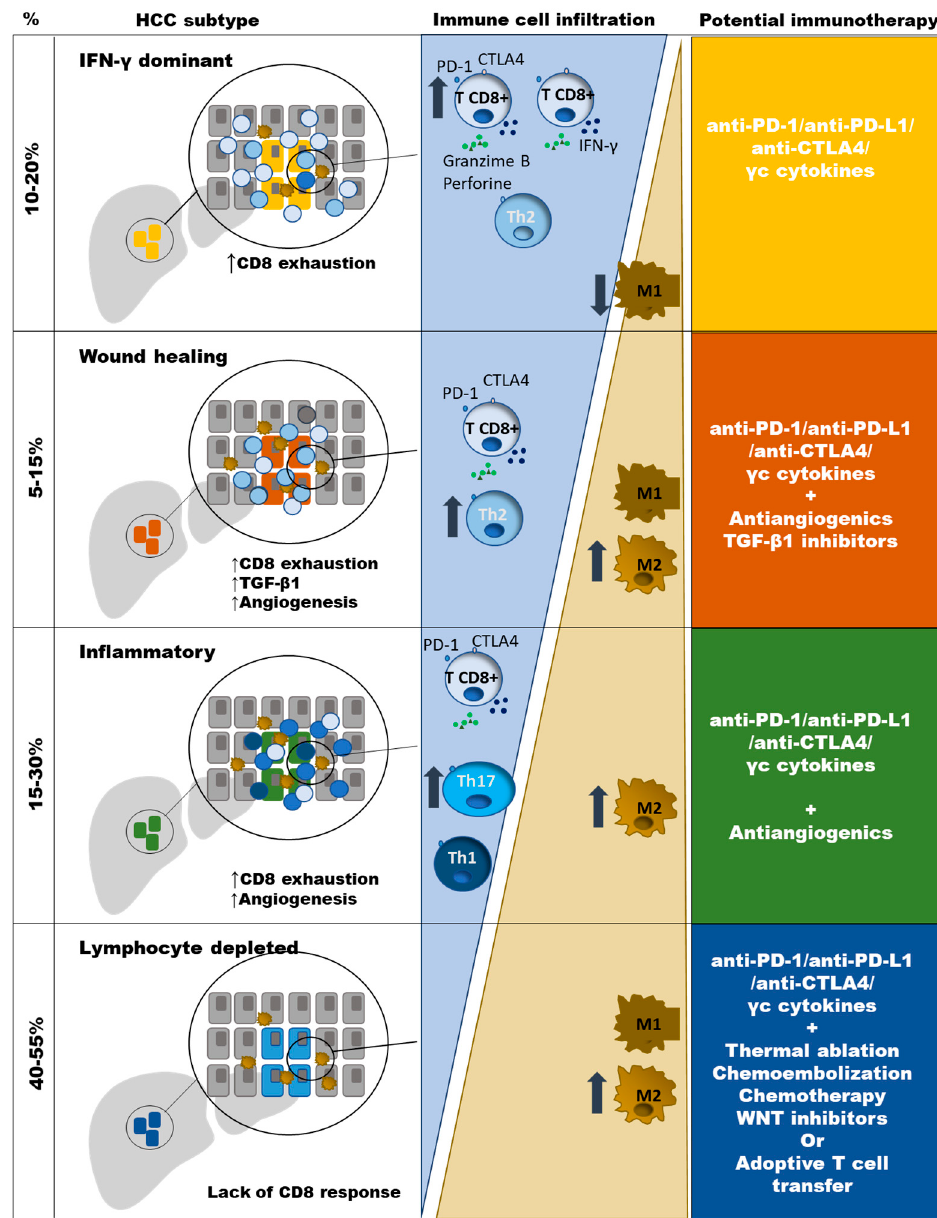
Figure 1. Type of anti-PD-1/PD-L1 based combination therapy, according to immune HCC subtypes. Progressive impairment in the balance between CD8 T cells and M2 TAM is observed in different HCC clusters. Neo-angiogenesis is induced in “Wound healing” and “Inflammatory” types. TGF-b1 genes are up-regulated in “Wound healing” HCC type. Absence of CD8 T cells in the “Lymphocyte depleted” type could be due to the lack of neoantigens or T cell deletion. TGF- β 1 dominant and the immunologically quiet clusters are poorly represented in HCC.